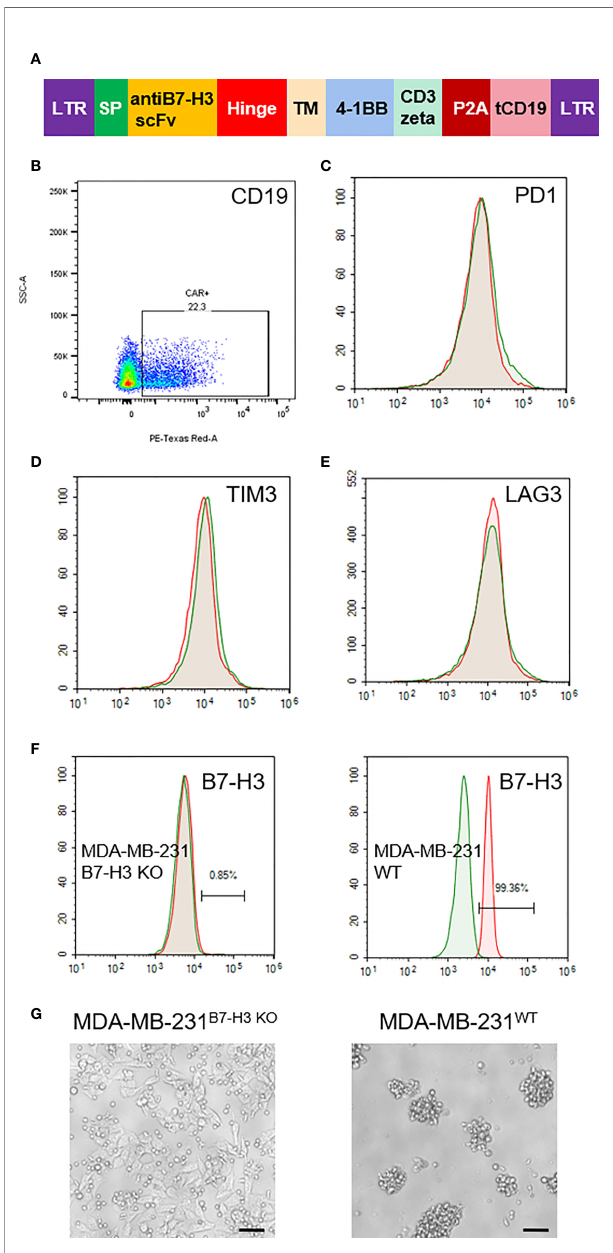
FIGURE 2 | Generation of B7-H3-retargeted CAR-T cells. (A) Scheme of lentivirus vector; SP, signal peptide; TM, transmembrane domain; tCD19, truncated CD19. (B) FACS examination of the transduction ef fi ciency of T cells by CAR lentivirus. (C – E) . FACS assays of the expression of PD-1, TIM3 and LAG3 on the CAR-T cells. (F) Expression examination of B7-H3 on MDA- MB-231 cells with B7-H3 KO and MDA-MB-231 wild type cells. (G) Cytotoxicity of B7-H3-retargeted CAR-T cells against MDA-MB-231 B7-H3 KO and MDA-MB-231 WT cells at a 2:1 E:T ratio. Scale bars: 50 m